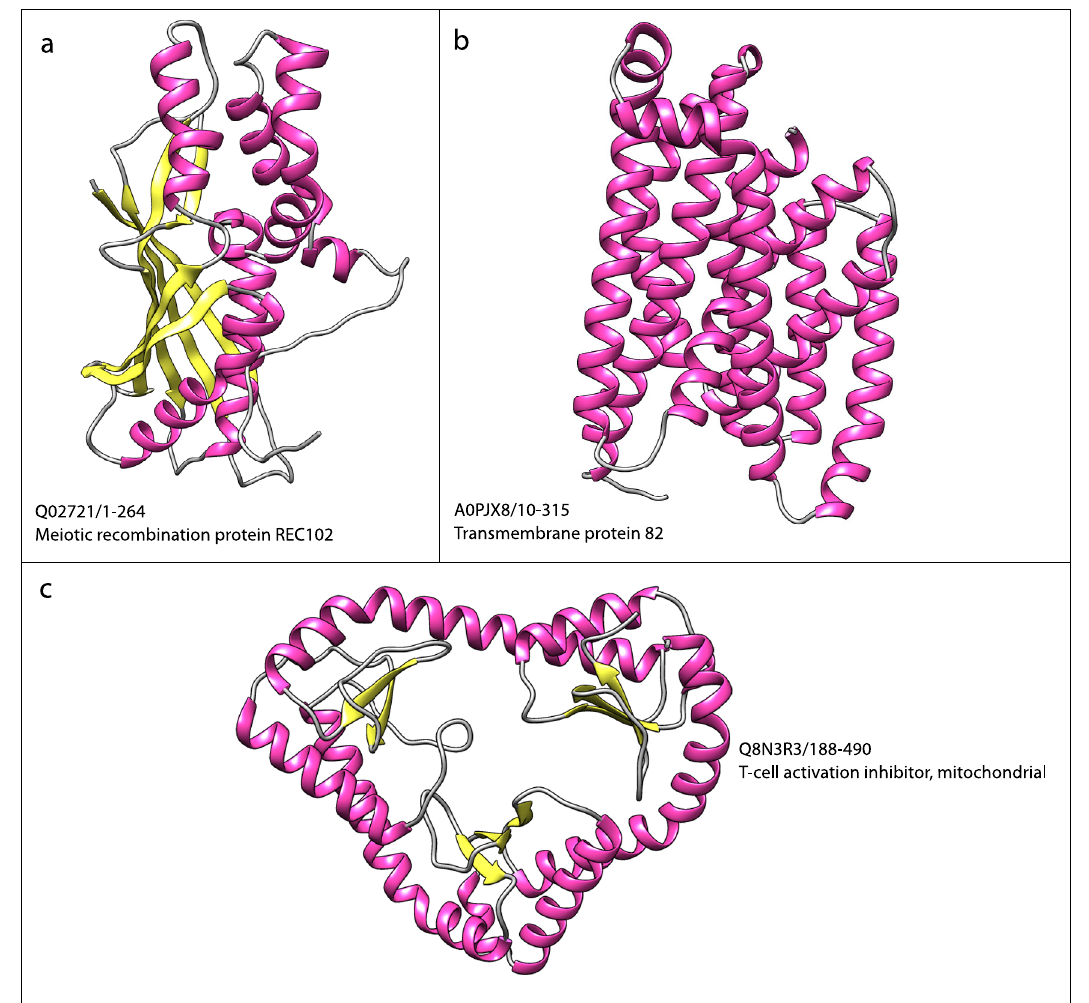
Fig. 8 New Structural Superfamilies. Each structure fi gure was generated using UCSF Chimera 36 , with identi fi ers in the format UniProt_ID/start-stop. a Meiotic recombination protein REC102. b Transmembrane protein 82. c T-cell activation inhibitor,